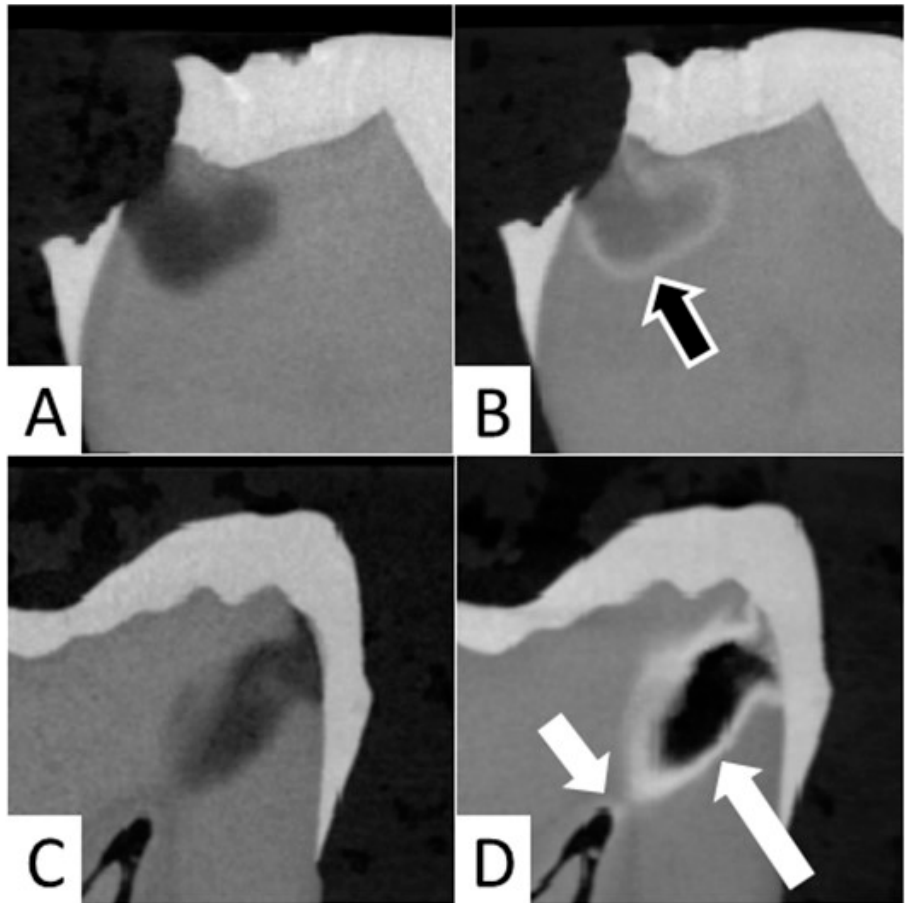
Figure 4. ( A , B ) Micro-CT images showing precipitation of SDF at the junction of affected and infected dentin (outlined arrow). ( A ) Preoperative image and ( B ) after SDF application. ( C , D ) Micro-CT image showing aggregation of SDF (white long arrow) and penetration of the SDF to the pulp chamber (short white arrow) ( C ) Preoperative image and ( D ) after SDF application.